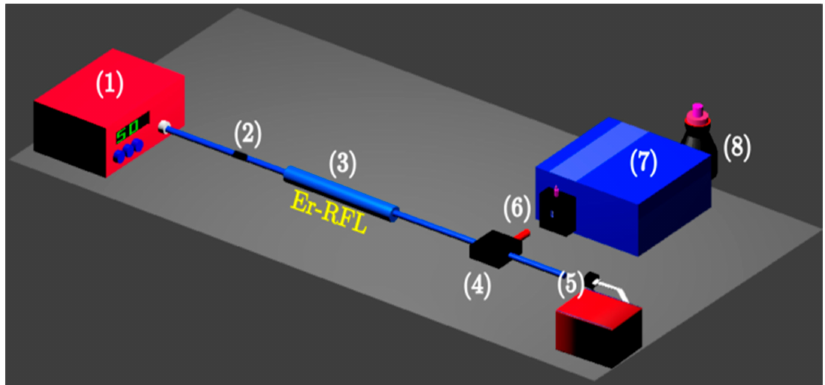
Figure 1. Experimental setup for the erbium-based random fiber laser (Er-RFL) system. (1) Fiber pigtailed semiconductor laser operating in the continuous-wave (CW) regime. (2) Fiber connector. (3) Er-doped RFL. (4) Wavelength-division multiplexer (WDM) 1480–1550. (5) Power meter to measure the output power P out at 1480 nm. (6) RFL emission out to the spectrometer. (7) Spectrometer. (8) Liquid-N 2 cooled InGaAs CCD camera. (Reproduced with permission from ref. [68]).